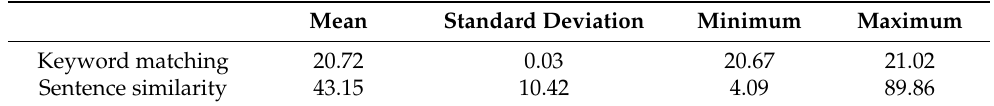
Table 6. Similarity score distribution